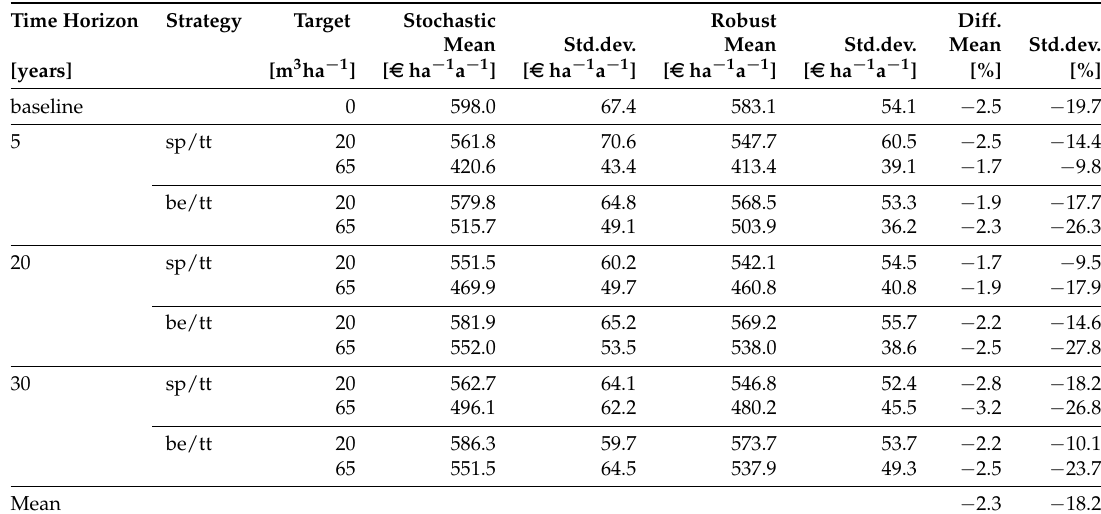
Table 6. Mean annuities and standard deviations of the stochastic model and the robust model derived from 100 Monte Carlo simulations of the uncertain possible revenues of each stand. Random values are chosen from the part of the uncertainty space that includes negative derivations from the nominal value. For abbreviations see Table